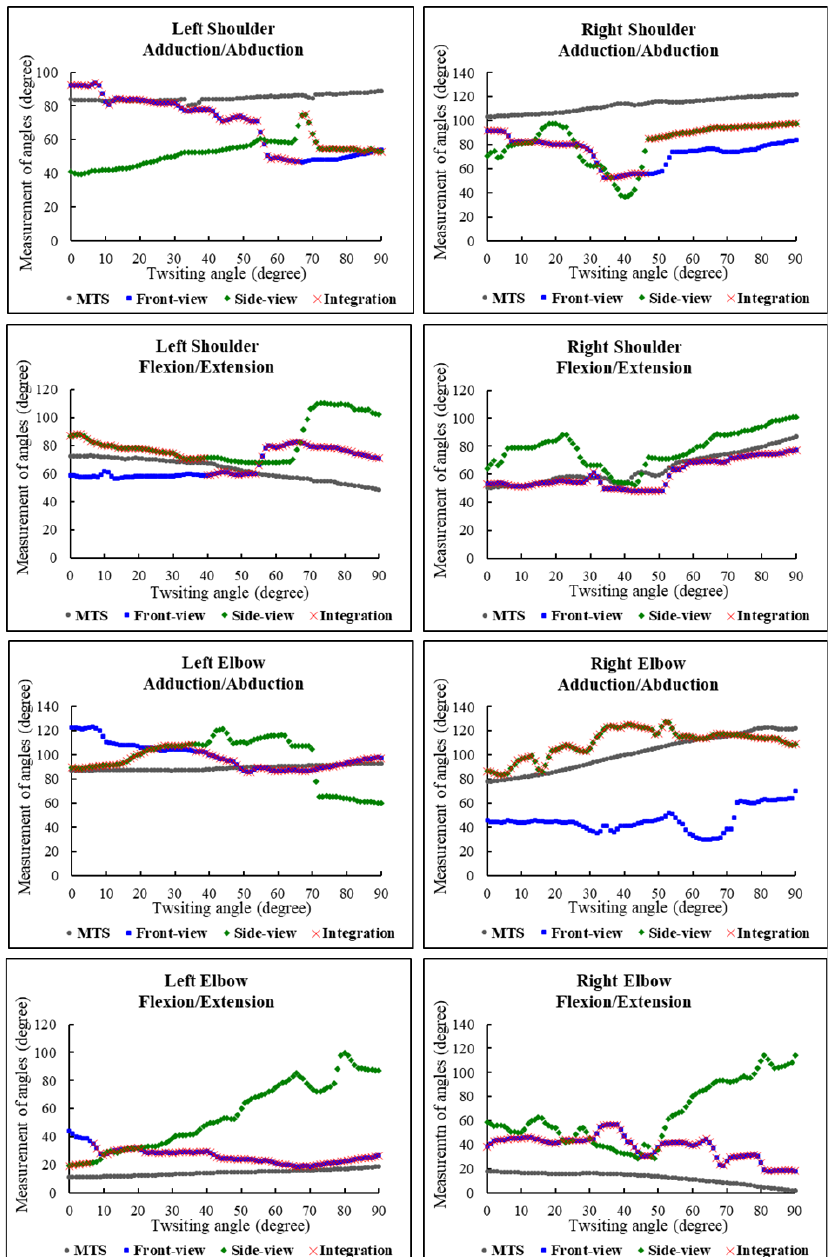
Figure 5. Representative example of the measured joint angle based on the Front-view Kinect, the Side-view Kinect, and the Integration Kinect with respect to the MTS. The gray circles represent the measurement obtained from the MTS, and blue squares and green diamonds indicate the data based on the Front-view Kinect, and the Side-view Kinect, respectively. The red cross sign marks are the data selected to form the Integration Kinect.